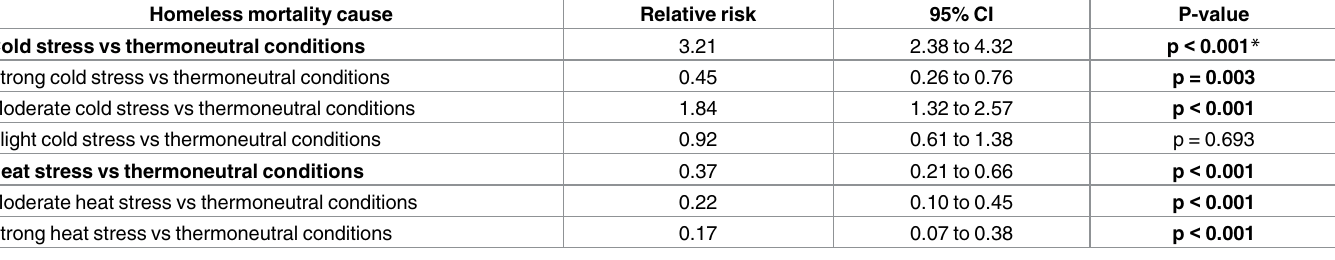
Table 4. Relative risks (RR) of mortality among the homeless population due to cold and heat stress (exposed group) in comparison to thermo- neutral conditions (control group). The RR and 95% confidenceinterval (CI) are calculatedaccordingto Altman 1991[29]. Homeless mortality